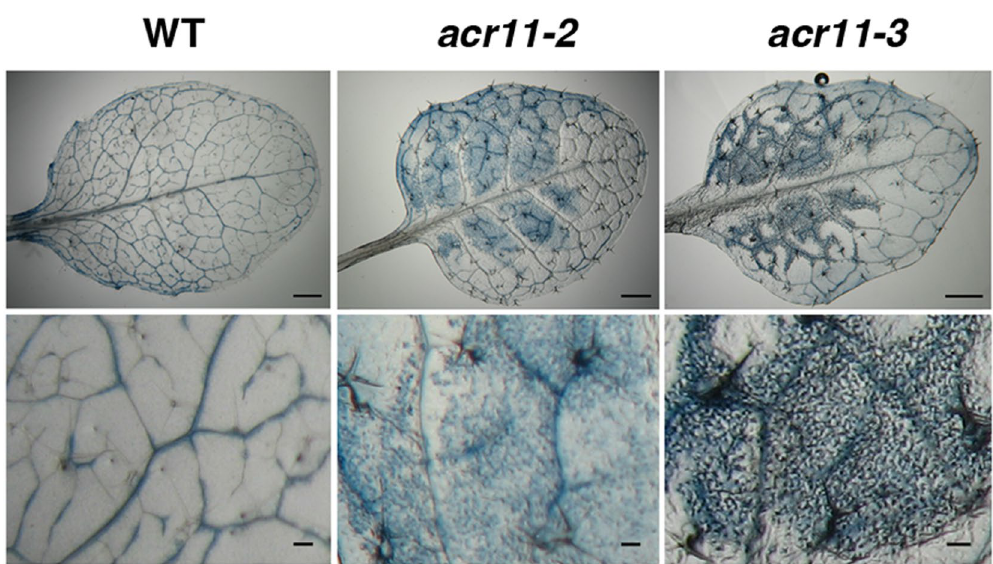
Figure 2. Trypan blue staining for the detection of cell death in the rosette leaves of 5-week-old Arabidopsis wild type (WT) and acr11 mutants. Scale bars are 1 mm (top) and 0.1 mm